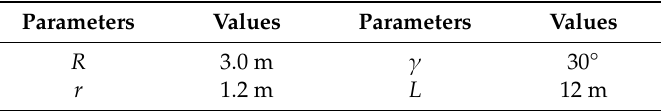
Figure 8. Flowchart of the reliability analysis. Table 10. Structural parameters of the floater.